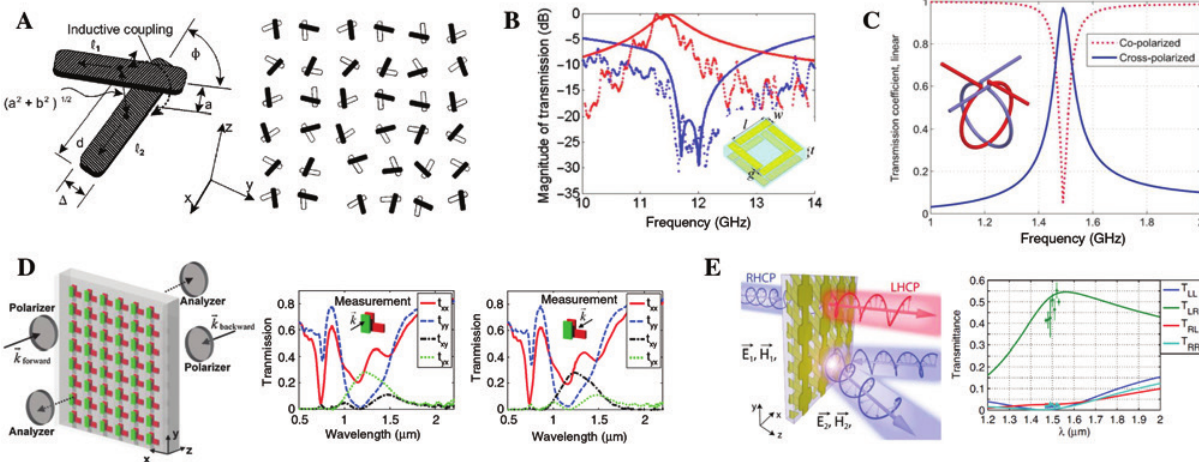
Figure 8: Metasurfaces for polarization rotation and asymmetric transmission. (A) A unit cell (left) and a bilayered planar chiral metasurface based on it with inductive cross-layer coupling (right). Reprinted figure from [158]. Copyright (2001) by AIP Publishing. (B) Transmission spectra for co- (blue) and cross-polarized (red) light. Simulated and meas- ured data are shown as solid and dotted lines, respectively. The inset shows the metasurface unit cell with fourfold rotational symmetry. Reprinted figure from [159]. Copyright (2010) by AIP Publishing. (C) Transmission spectra for co- and cross-polarized incident waves. The inset depicts the metasurface unit cell with canonical twisted helices. Reprinted figure from [96]. Copyright (2013) by IEEE. (D) Left: A metasurface asymmetrically transmitting linearly polarized light from the opposite sides and a schematic of the experimental setup. Right: Measured transmission spectra for illuminations along the + z (left plot) and − z (right plot) directions. Reprinted figure from [160]. Copyright (2010) by the American Physical Society. (E) Left: Artistic illustration of a metasurface which asymmetrically transmits circularly polarized light. RCP light incident from the left side is converted into LCP, while RCP light is completely reflected when incident from the right side (for visual clarity, the incident wave from the right side is shown as oblique). Right: Measured and simulated Jones matrix of the metasurface. “L” and “R” denote LCP and RCP light. Reprinted figure from [51]. Copyright (2014) by the American Physical